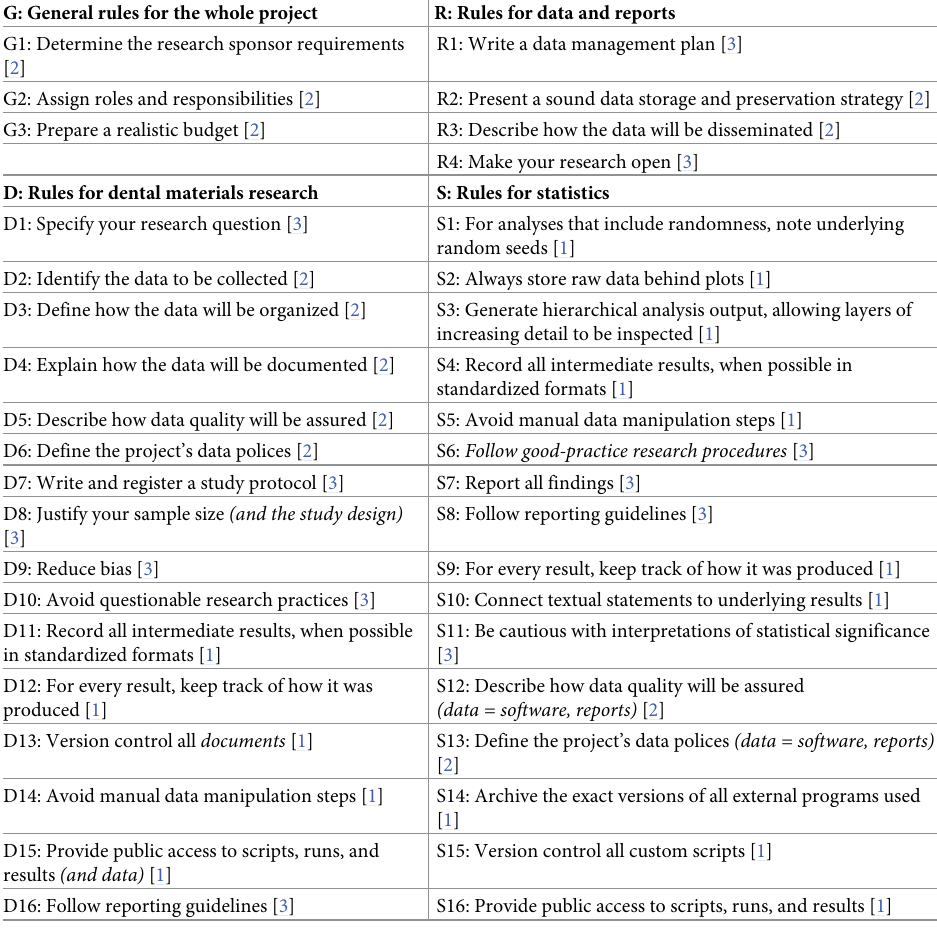
Table 1. Rules from [1–3] used to design the project outlined in Fig